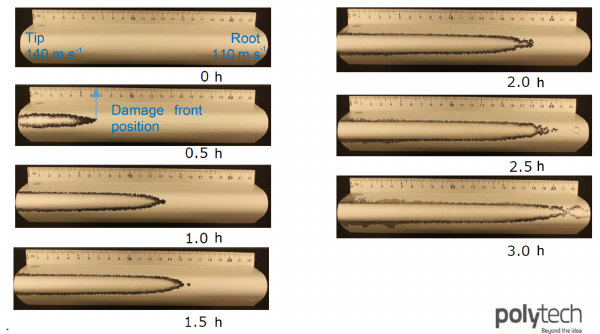
Figure 3. Time to removed coating as a function of the local rotor speed.